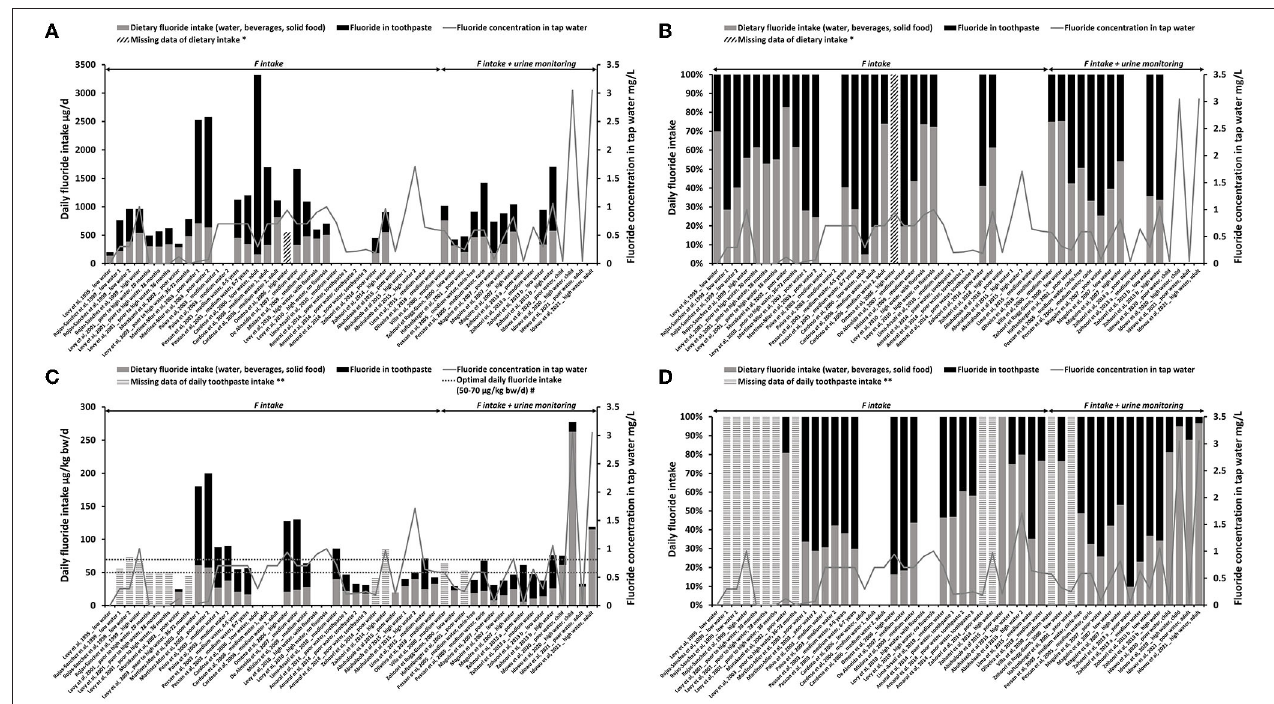
FIGURE 2 | Estimated F intake from diet (water, beverages, and solid foods) (gray bars) and from toothpaste (black bars). F concentration in tap water is represented by the gray line (mg/L). (A) Total daily fluoride intake with dietary and toothpaste inputs ( µ g/day). (B) The contribution of daily diet (water, beverages, and solid foods) and toothpaste (%) to the estimated F intake in µ g/day [based on (A) ]. (C) TDFI with dietary and toothpaste inputs ( µ g/kg bw/day) with reference values of optimal daily F intake [50–70 µ g/kg bw/day, the European Food and Safety Authority (EFSA)]. (D) The contribution of daily diet (water, beverages, and solid foods) and toothpaste (%) to the estimated F intake in µ g/kg bw/day [based on (C) ]. *Diagonal hatched bars represent missing data of daily dietary F intake (DDFI). **Horizontal hatched bars represent missing data of daily F intake from toothpaste. # Optimal range of daily F intake reported in the